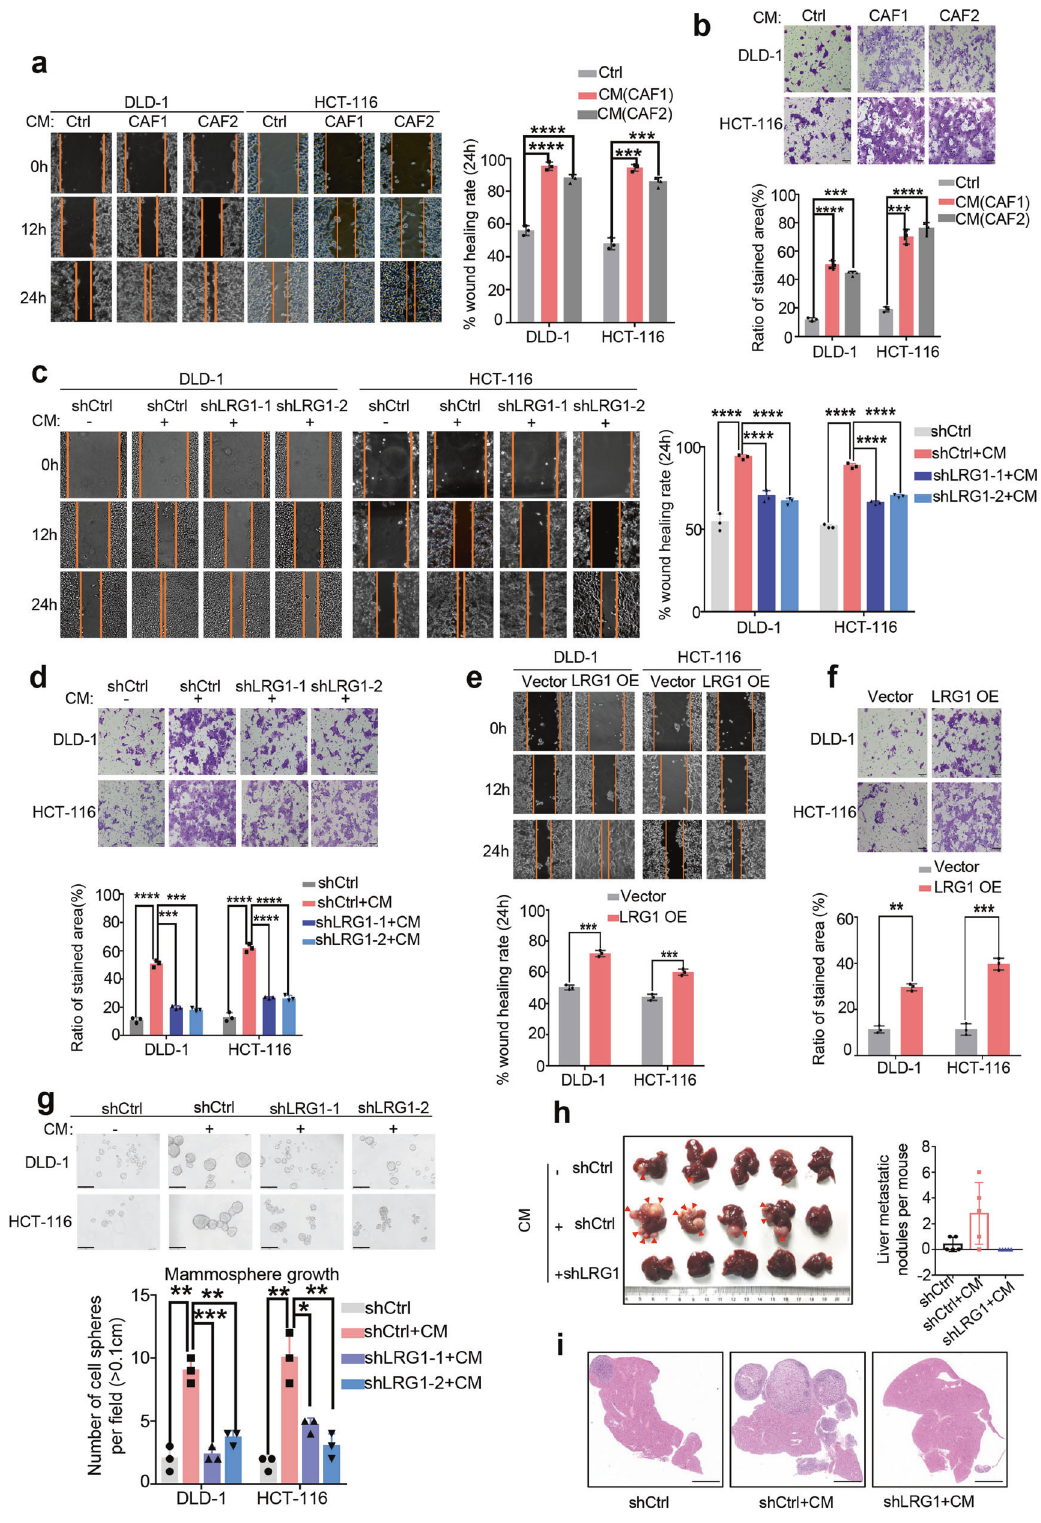
analysis of LRG1 and two typical EMT markers including